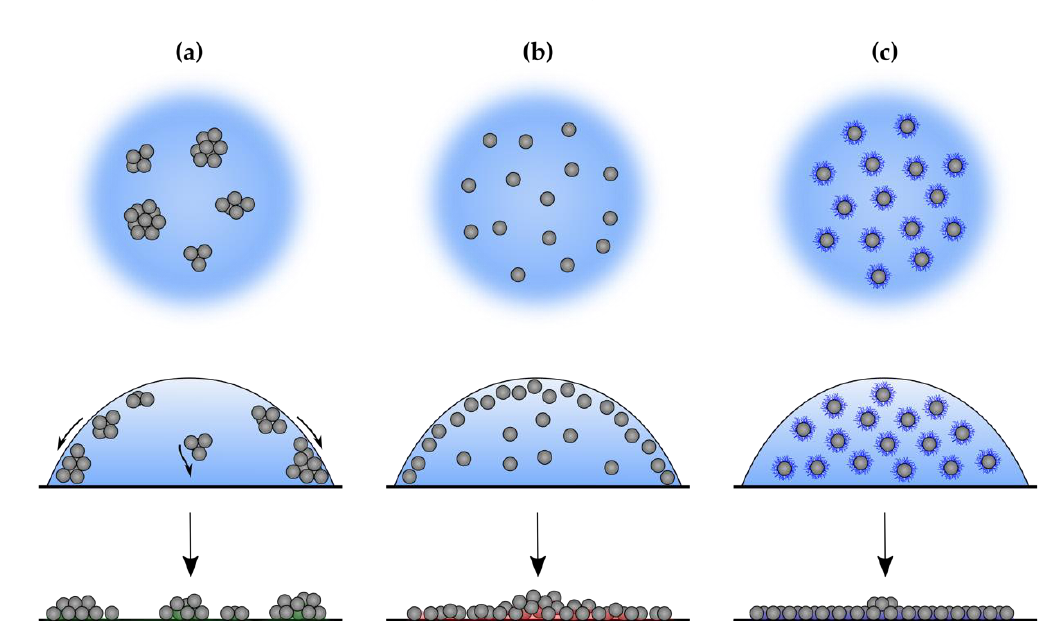
Figure 10. Schematic illustration of particles distribution within the suspension ( top ), sessile droplet ( middle ) and electrode surface ( bottom ) for different binders: ( a ) cationic chitosan; ( b ) anionic Nafion, ( c ) nonionic PVP.